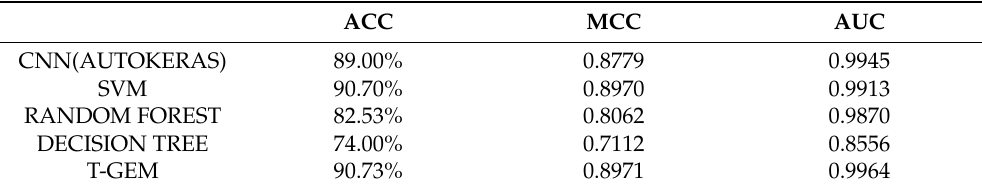
Table 5. Performances of T-GEM and benchmark models for cell type classification using PBMC scRNA-seq